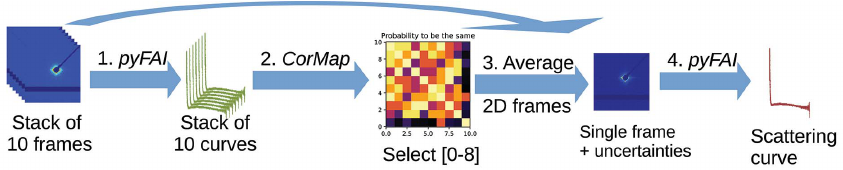
Figure 4 Schematic of the multi-frame integration pipeline: 1, zimuthal integration of individual frames; 2, comparison of 1D curves (the first nine frames are equivalent, the tenth is discarded); 3, equivalent frames are averaged; 4, azimuthal integration of the averaged